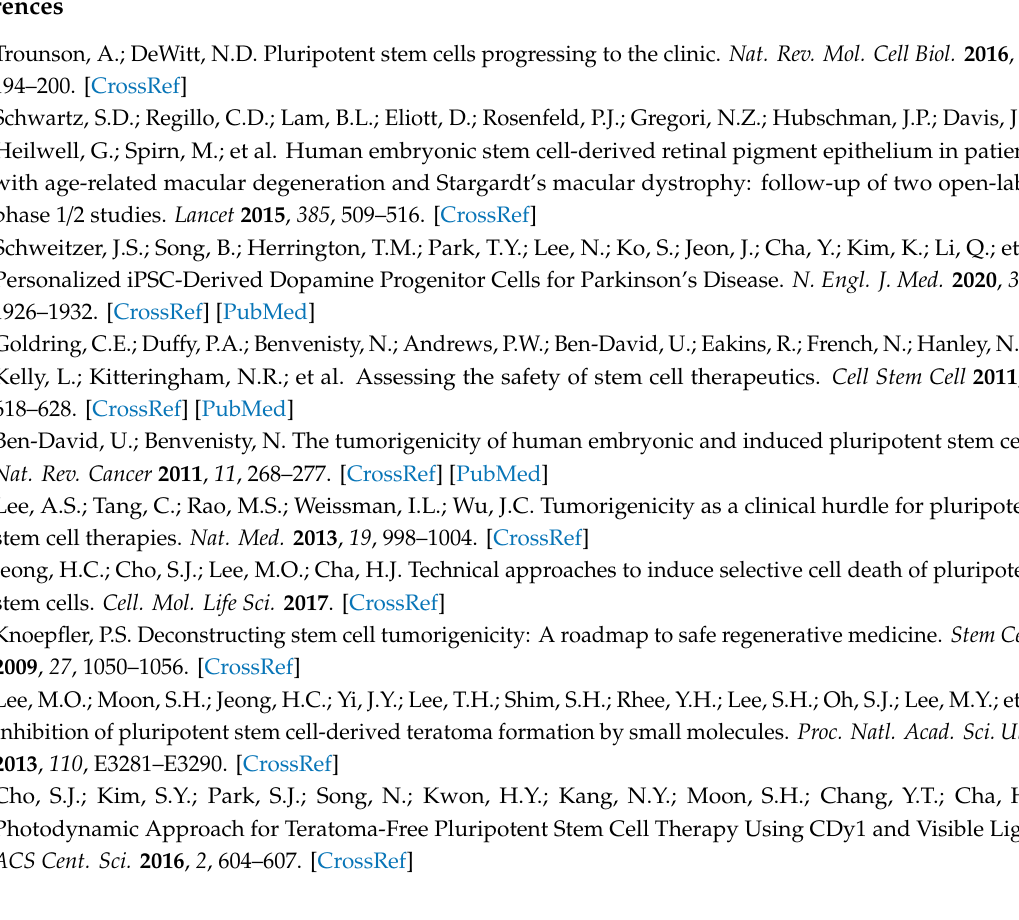
Figure S1: The e ff ect of glycoside analogues in hESCs. Figure S2: IC 50 plot of LUT and QC. Movie S1: Real time images of hESCs after treatment of QC or LUT. Movie S2. Real time image of spontaneous contraction in hESC-CMs. Movie S3. Real time fluorescence image of Ca 2 + oscillation in hESC-CMs. Movie S4. Real time fluorescence image of Ca 2 + oscillation in hESC-CMs after treatment of